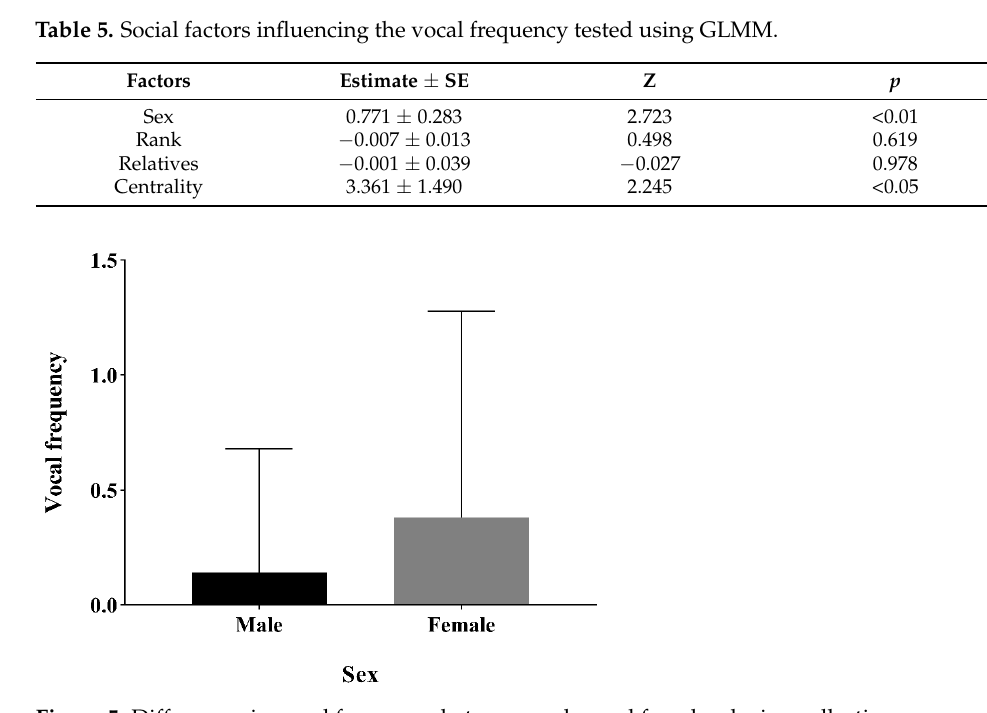
Figure 5. Differences in vocal frequency between males and females during collective movements. The vertical axis represents the vocal frequency of individuals. The larger the vocal frequency, the more frequently the individual